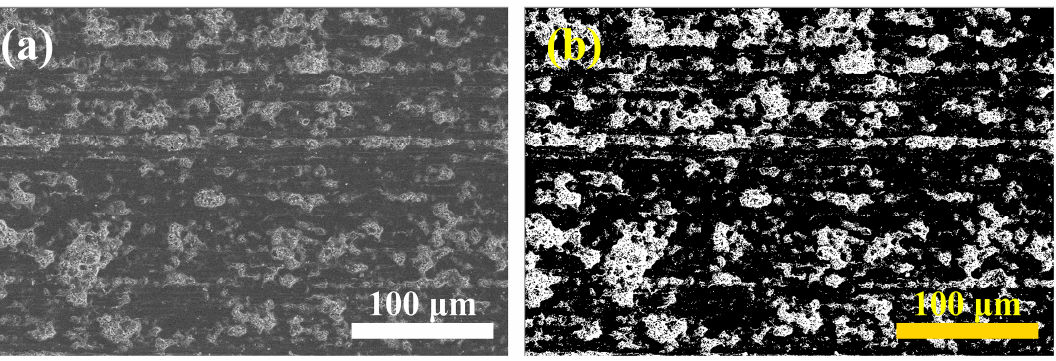
Figure 2. ( a ) The original SEM image of the sawed surface; ( b ) the binarized image after processing by the MATLAB script.